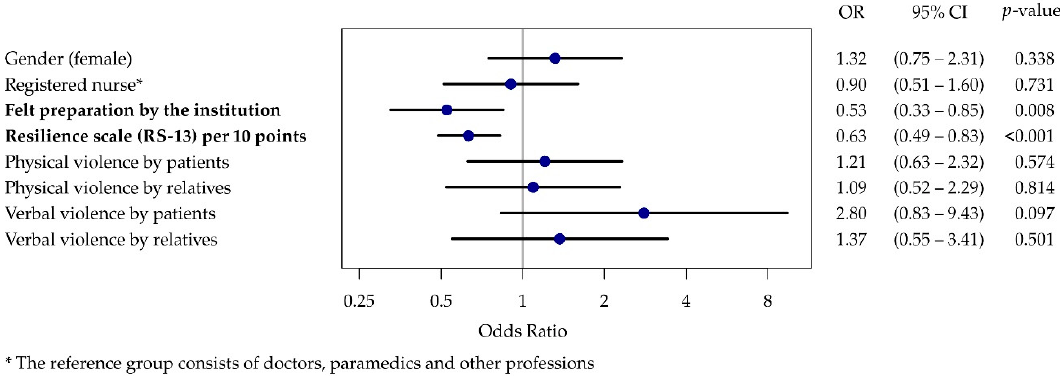
Figure 3. Forest plot of the ordinal regression results for patient-related burnout.